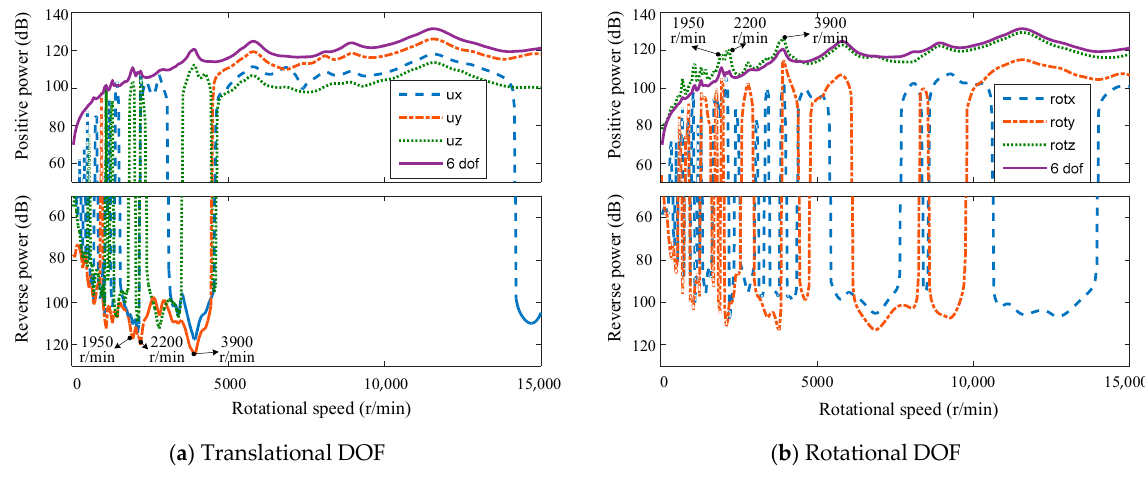
Figure 8. Excitation power fl ow of gear pair—direction path.